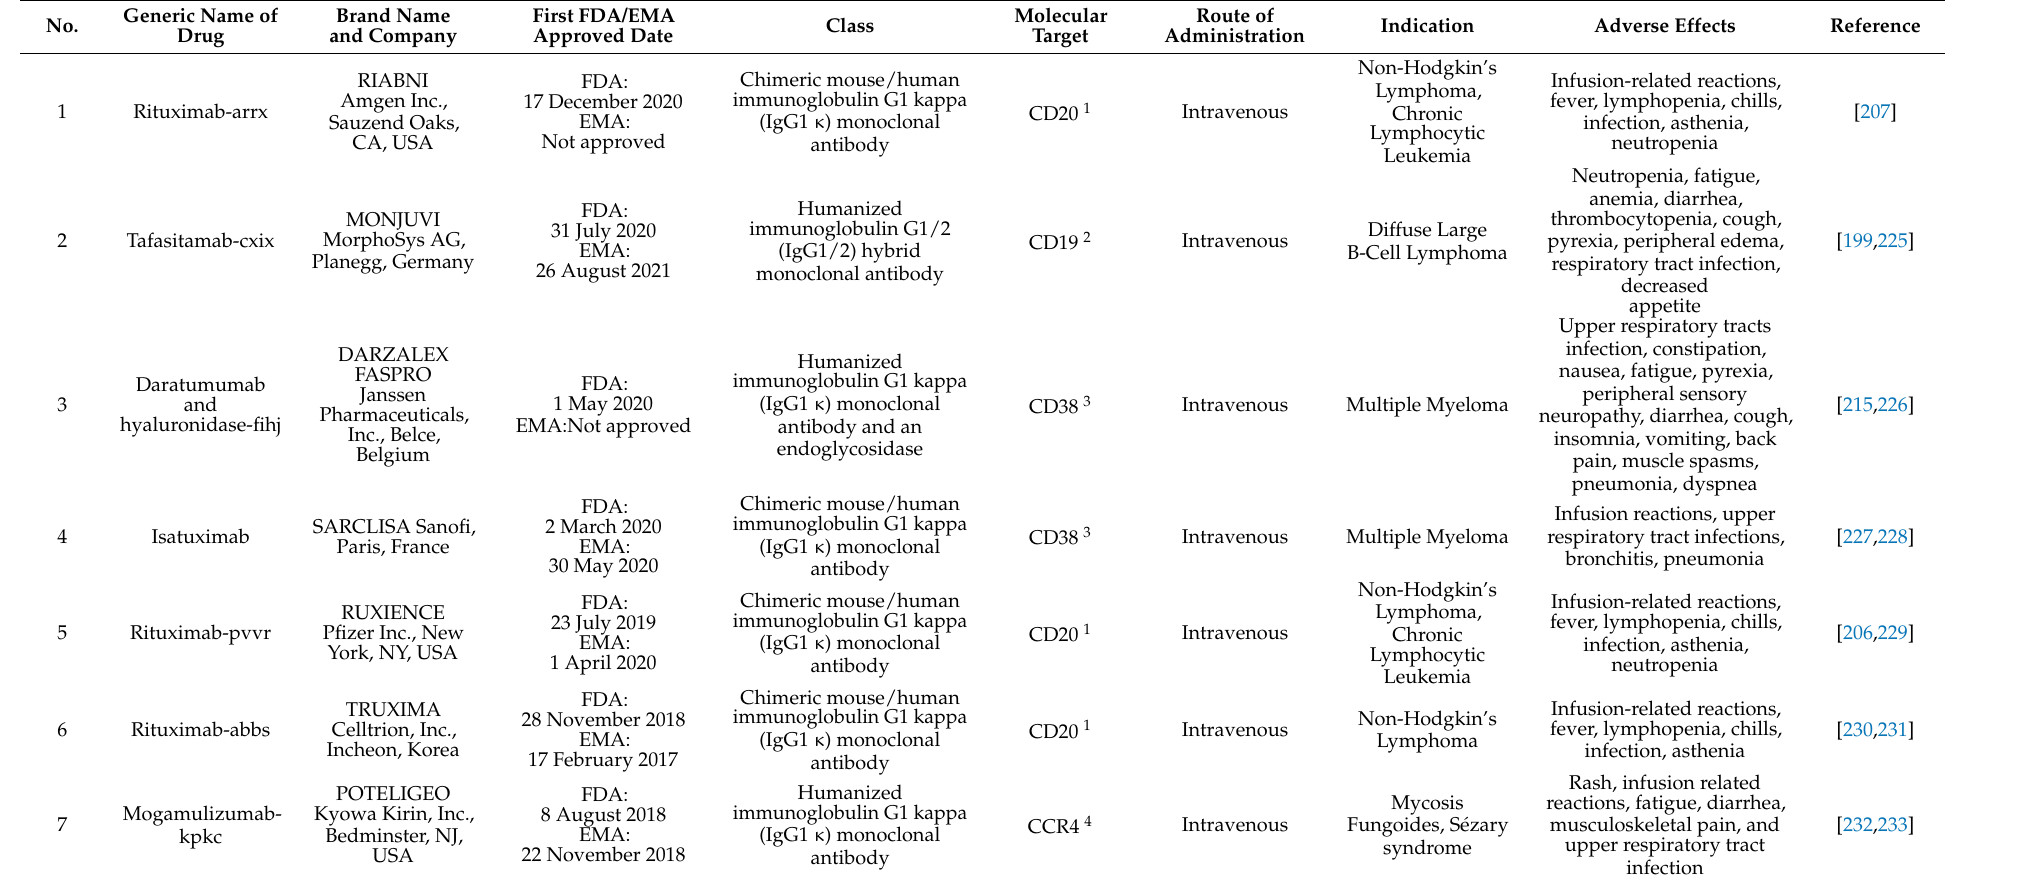
Table 11. Features of the monoclonal antibody drugs approved by the Food and Drug Administration (FDA) from 2011 to 2021. The order of drugs is tabulated in order of most recent to oldest registration